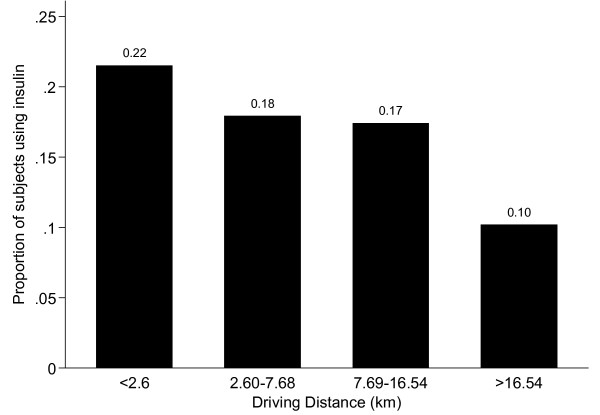
Insulin use over the range of driving distances. Driving distances were divided into quartiles of 195 or 196 subjects each. The heights of the bars represent the proportion of subjects in each quartile who use insulin.